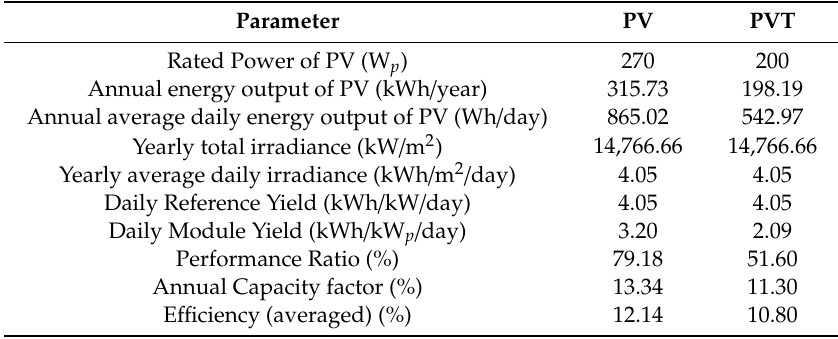
Table 6. A summary of PV and PVT (electrical properties)